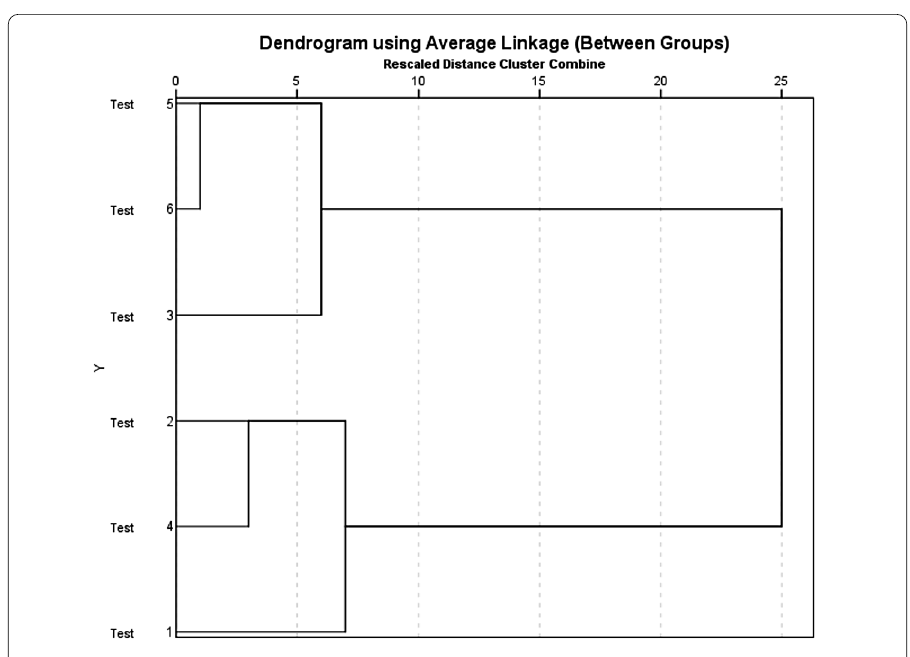
Figure 2 Dendrogram